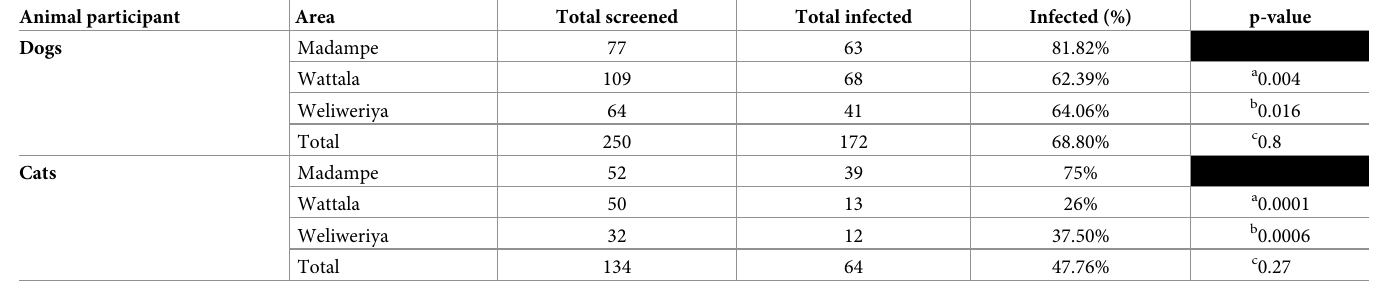
Table 3. Comparison of area-wise prevalence of microfilaraemia among cats and dogs. Animal